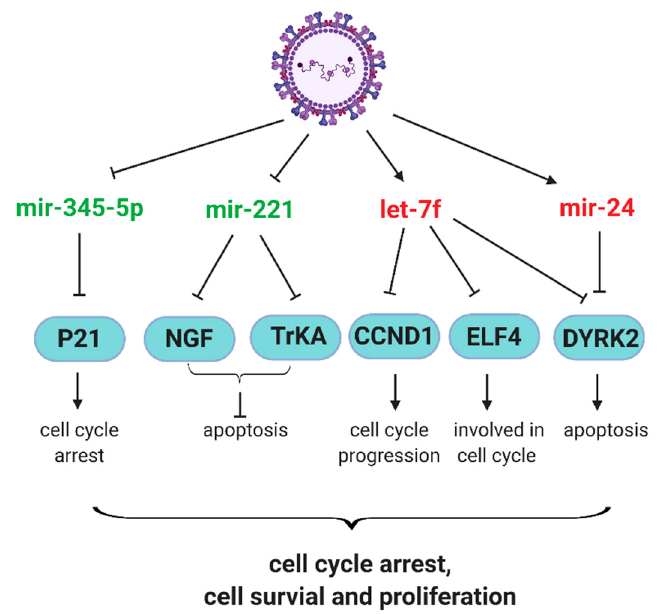
Figure 2. Schematic diagram of the effect of RSV-regulated miRNAs on cell survival. RSV-induced and -decreased miRNAs are indicated in red and green, respectively. Arrows mark and stop bars respectively denote the positive and negative effects on the downstream molecules.